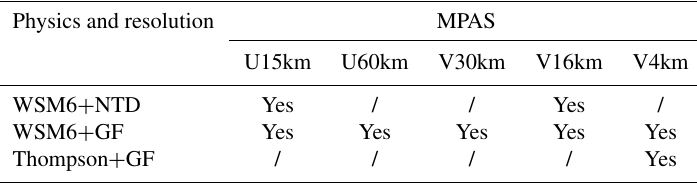
Table 1. Numerical experiments conducted and analyzed in this study. Physics and resolution MPAS U15km U60km V30km V16km V4km WSM6 + NTD Yes WSM6 +